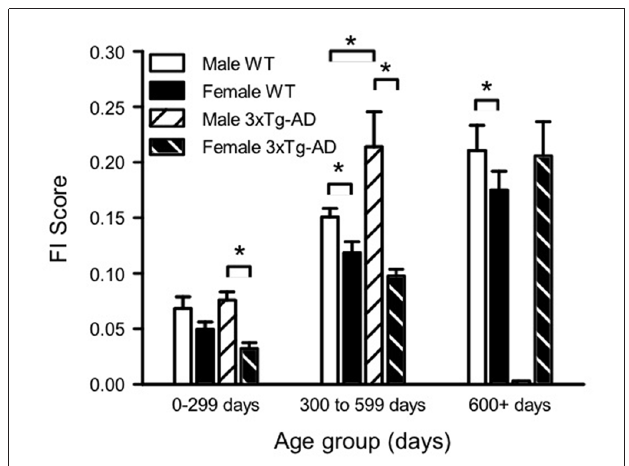
FIGURE 3 | Sex and genotype differences in mean FI scores over the lifespan. Mean FI scores were plotted for each sex and genotype group at three different ages (0–300 days, 300–600 days and 600+ days). Analysis was completed with 3-way and 2-way analyses of variances (ANOVAs) with Bonferroni post hoc testing. Three-way ANOVA showed a significant effect of age and sex, and 2-way ANOVA showed a significant effect of genotype for males only. Two-way ANOVAs of age group and either sex or genotype showed that for all groups, mean FI scores increased with increasing age (statistics not shown on graph). ∗ p < 0.05 between sexes. 0–300 days Male WT n = 23, Male 3xTg-AD n = 26, Female WT n = 22, Female 3xTg-AD n = 19; 300–600 days Male WT n = 47, Male 3xTg-AD n = 9, Female WT n = 41, Female 3xTg-AD n = 25; 900 + days Male WT n = 17, Male 3xTg-AD n = 0, Female WT n = 29, Female 3xTg-AD n =